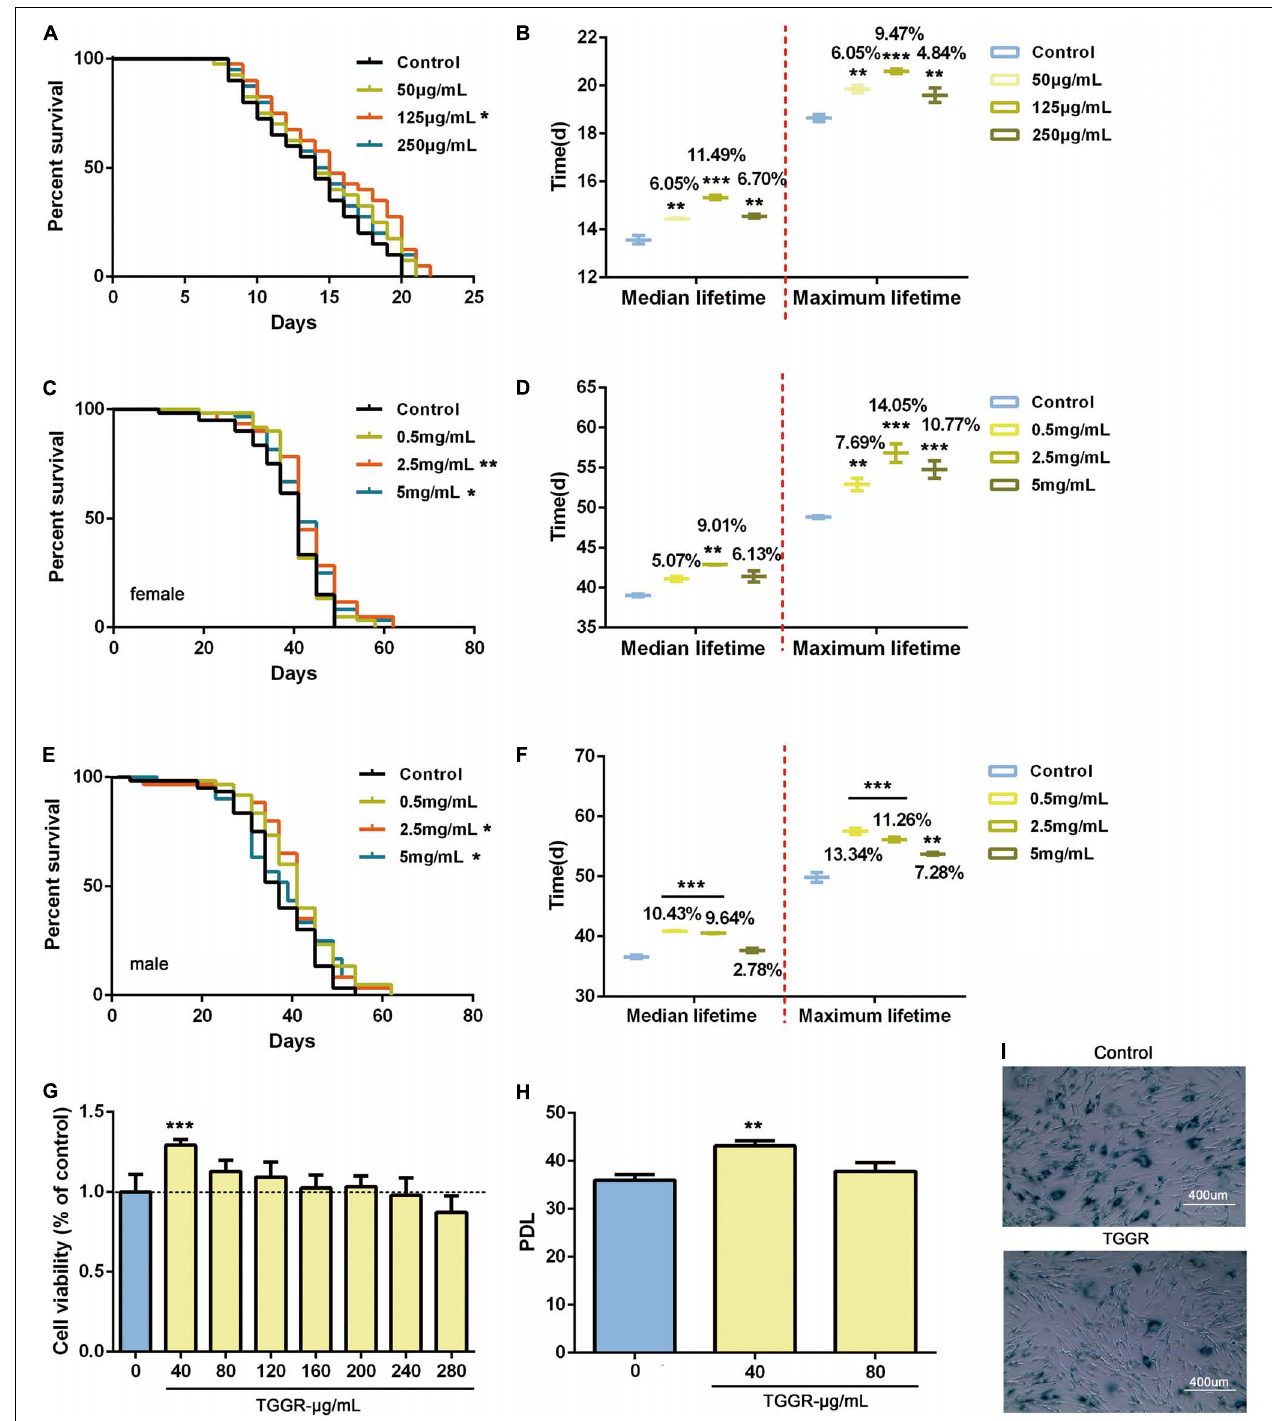
FIGURE 1 | TGGR promotes longevity in C. elegans, Drosophila and human cells. Survival of nematodes (A,B) , flies (C–F) , and MRC-5 cells (G–I) during aging with supplementation of medium with TGGR. Representative survival curve (A) and median and maximal lifespan (B) in nematodes ( N = 80 nematodes, one-way ANOVA). Survival curve and associated pairwise log-rank tests in female (C) and male flies (E) . The median and maximal lifespan in female (D) and male flies (F) ( N = 120 flies, two-tailed unpaired t -test). (G) CCK-8 assays to detect the effect of TGGR on the viability of MRC-5 cells ( N = 6, one-way ANOVA). (H) Effect of TGGR on the population doubling level (PDL) of MRC-5 cells [PDL = 3.32 (logN2-logN1) + X, where “N2” is the number of harvested cells of this generation, “N1” is the number of inoculated cells of the previous generation, and “X” is the PDL of the previous generation of cells] ( N = 3, one-way ANOVA). (I) Aging-related galactosidase staining (SA- β -gal). Senescent cells are stained dark blue-green, and have increased cell volume and irregular shapes. * p < 0.05, ** p < 0.01, *** p < 0.001 vs. the control.